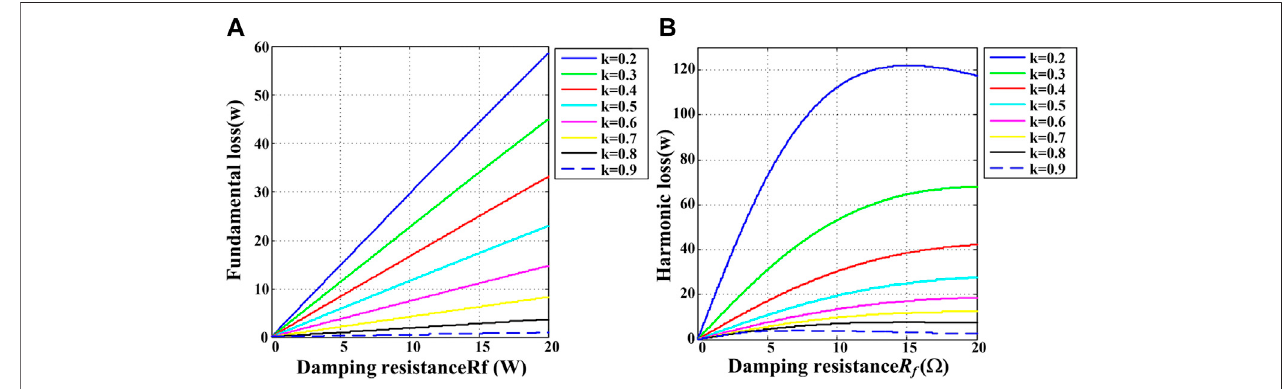
FIGURE 5 | Relation between power loss of R f , inductor ratio k , and resistor of R f . (A) Fundamental wave loss. (B) Harmonic